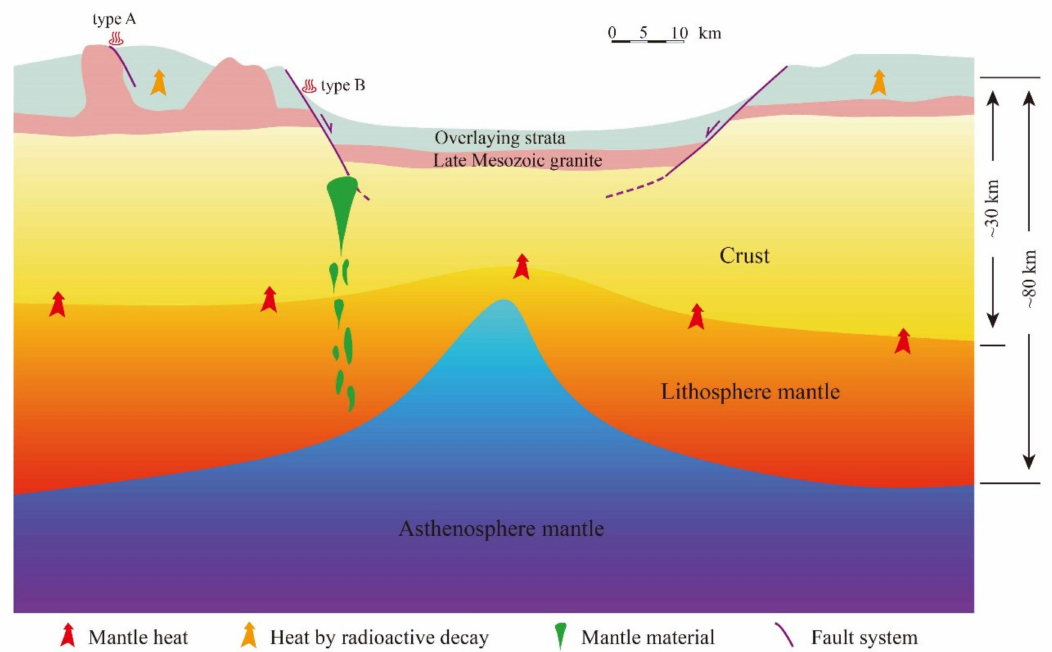
Figure 9. A model of the crust–mantle structure to decipher geothermal formation in Guangdong Province. The granite layer was modified from Kuang et al.